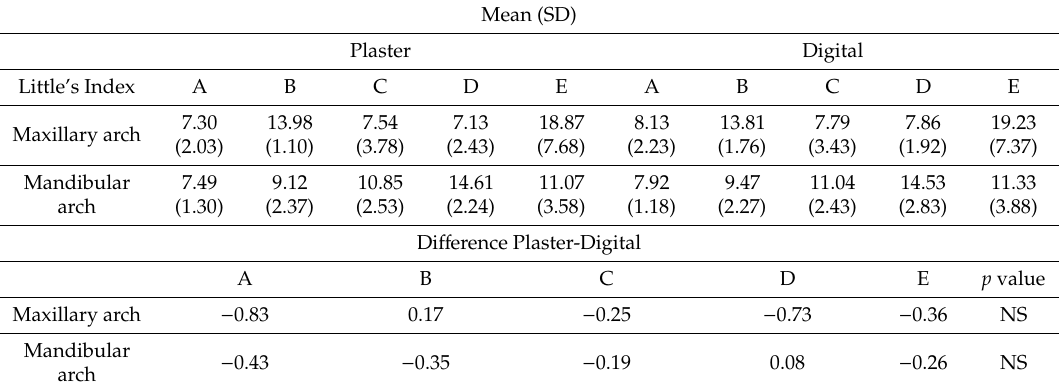
Table 4. Mean values and di ff erence between the plaster and digital measurements (ABO score) for each group of